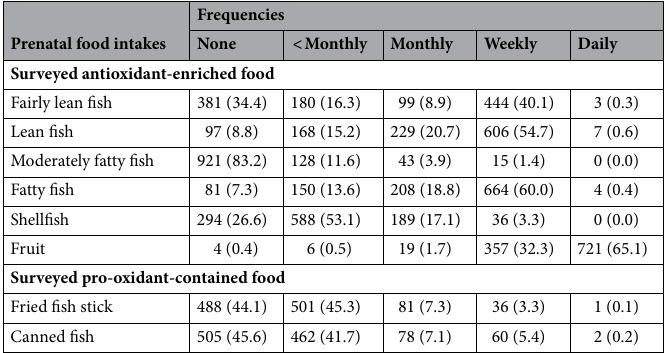
Table 1. Distributions of prenatal surveyed antioxidant-enriched and pro-oxidant-contained food consumption by frequencies among term newborns in the Gene and Environment Interaction Birth Cohort Study in Northern Taiwan. Values are presented as n